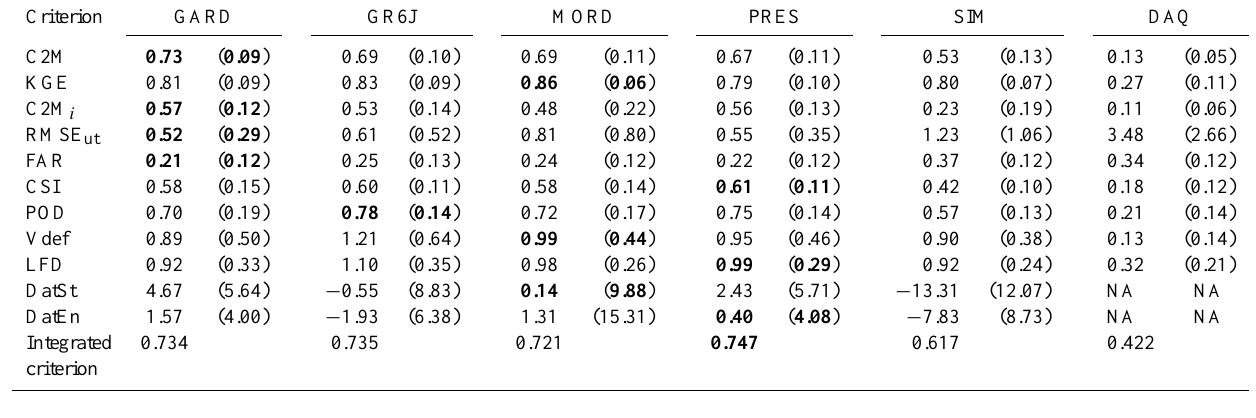
Table 6. Models’ mean performances (with standard deviation in brackets) in validation on the 21 catchments for the simulation mode. The integrated criterion is calculated in the nine low-flow criteria (i.e. not considering C2M and KGE) and on transformed values of criteria. Bold values indicate the best model.